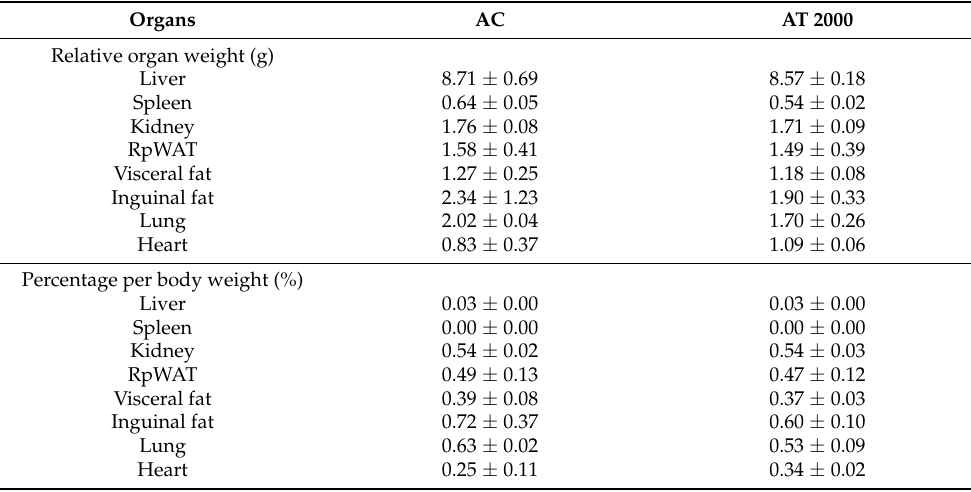
Table 4. Relative organ weight of SD female rats in acute toxicity study. Values expressed as mean ±